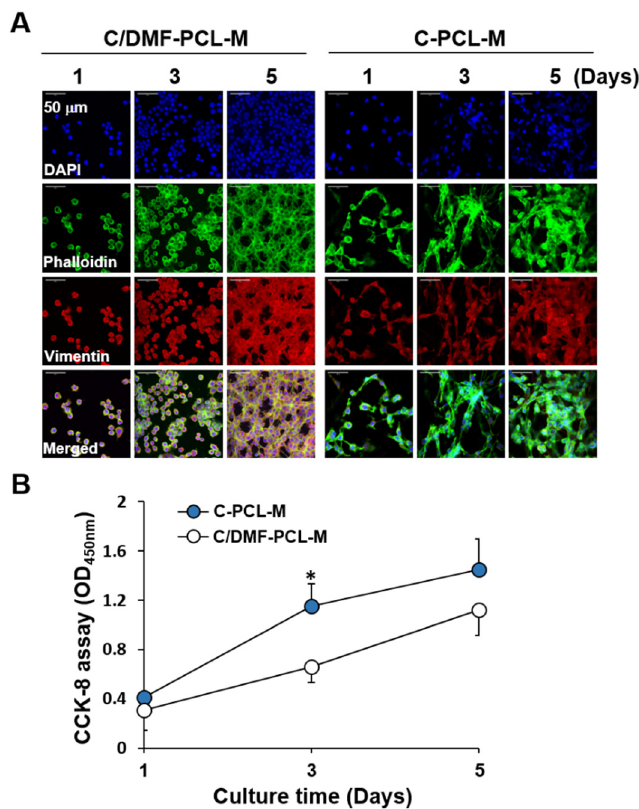
Figure 3. The growth of CT26 cancer cells on C / DMF-PCL-M and C-PCL-M. CT26 cells (3 × 10 4 ) were top-seeded on the C / DMF-PCL-M and C-PCL-M and cultured for the indicated periods ( n = 3). ( A ) Cell morphology was evaluated via confocal microscopy after immunofluorescence staining of the cells with DAPI (blue), phalloidin (green), and anti-vimentin antibody (red). ( B ) Proliferation rates of the CT26 cells were analyzed using the CCK-8 assay. Data represent three independent experiments. * p < 0.05, compared to C / DMF-PCL-M.